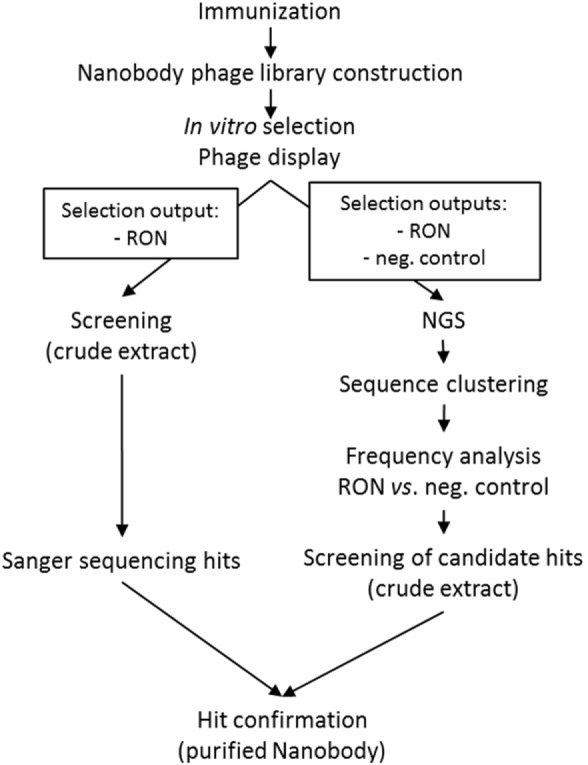
Schematic overview of the work flows for the next-generation sequencing and conventional screening campaigns.